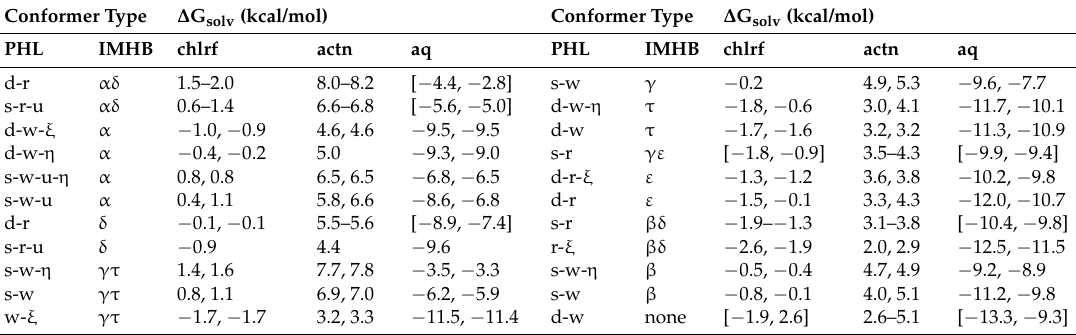
Table 10. Ranges of the free energy of solvation ( Δ G solv ) in the solvents considered DFT/B3LYP/6- 31+G(d,p) results from single point PCM calculations in solution. The types of conformers are characterised by the features that prove relevant in relation to the ranges of the given dipole moment, i.e., the first IHB and the orientations of the other phenol OH (under the PHL heading) and the types and combinations of IMHB (under the IMHB heading). When only two values are available for a given type, they are both reported, separated by a comma. Ranges negative numbers are indicated by reporting the two end-values in brackets, separated by a comma; e.g., [ − 4.4, − 2.8] indicates a range whose lowest value is − 4.4 and whose highest value is − 2.8.